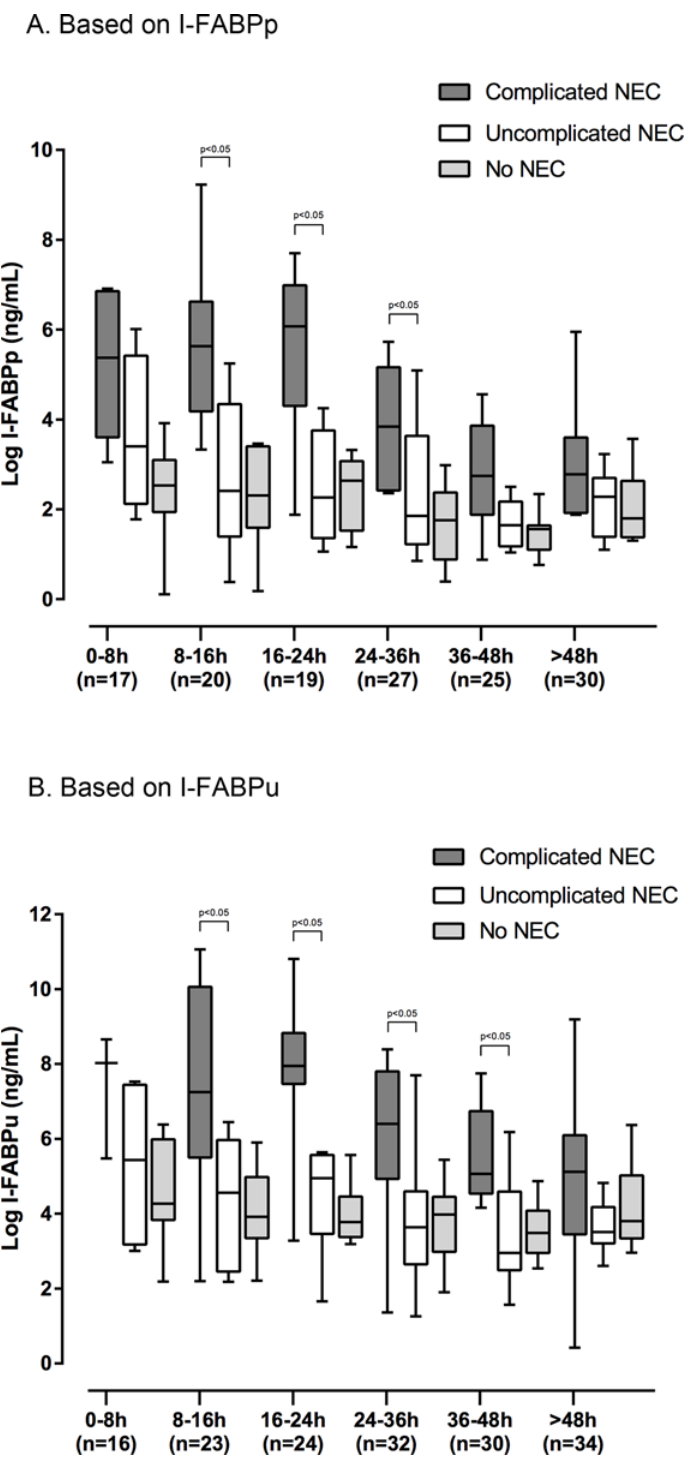
Fig 3. Box plots depicting median I-FABP values (after logarithmic transformation) measured in plasma (A) and urine (B) of all patients during the course of disease. A. Based on I-FABPp. B. Based on I-FABPu.